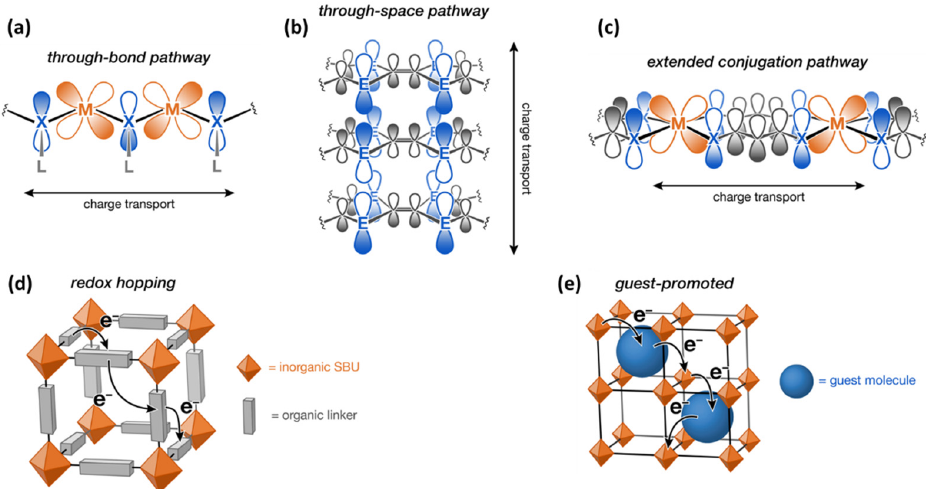
Figure 6. Various mechanisms of charge transport ( a – e ) possible in MOFs [29].